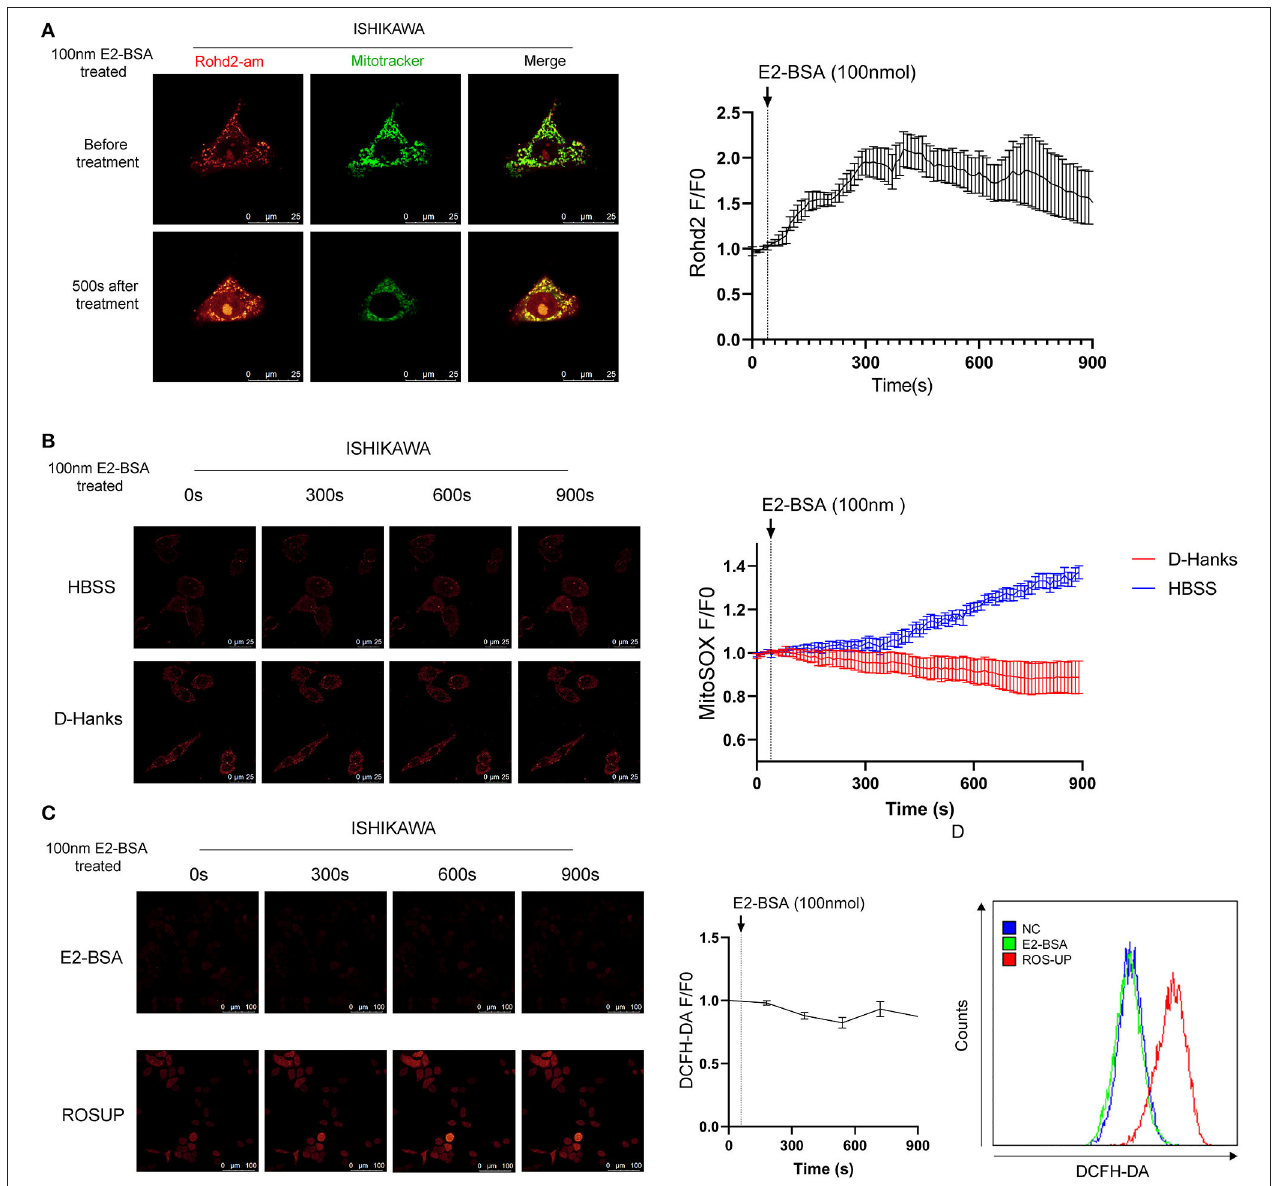
FIGURE 4 | The influence of estrogen-regulated calcium influx in the mitochondrion of Ishikawa cell line. (A) The effect of E2-BSA induced calcium influx of mitochondrion calcium in the Ishikawa cell line. Rohd2-am (red) was used to label the calcium of mitochondrion. (B) Influence of calcium influx of mitochondrion ROS. Magnification 63 × . Scale bar 25 µ m. (C,D) Confocal images and flow cytometry of the influence of calcium influx of intracellular total ROS level detected by DC-FHDA. Magnification 63 × . Scale bar 100 µ m. All data are presented as the means ± SE. n = 50 for cell numbers and n = 3 for